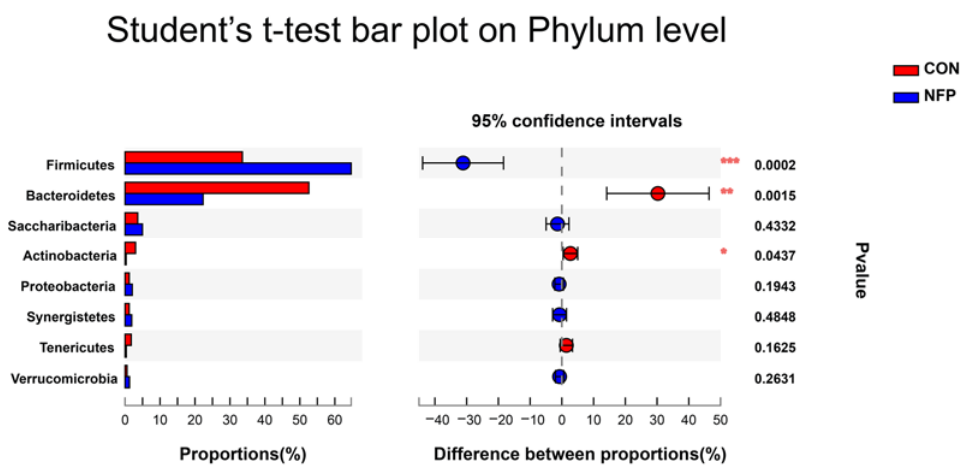
Figure 4. Statistical analysis of different bacterial taxa at the phylum level by Student’s t ‐ test in Exp. 2 (* 0.01 < p ≤ 0.05, ** 0.001 < p ≤ 0.01, *** p ≤ 0.001). Table 8. Relative abundance of main bacterial phyla and genera in Exp.